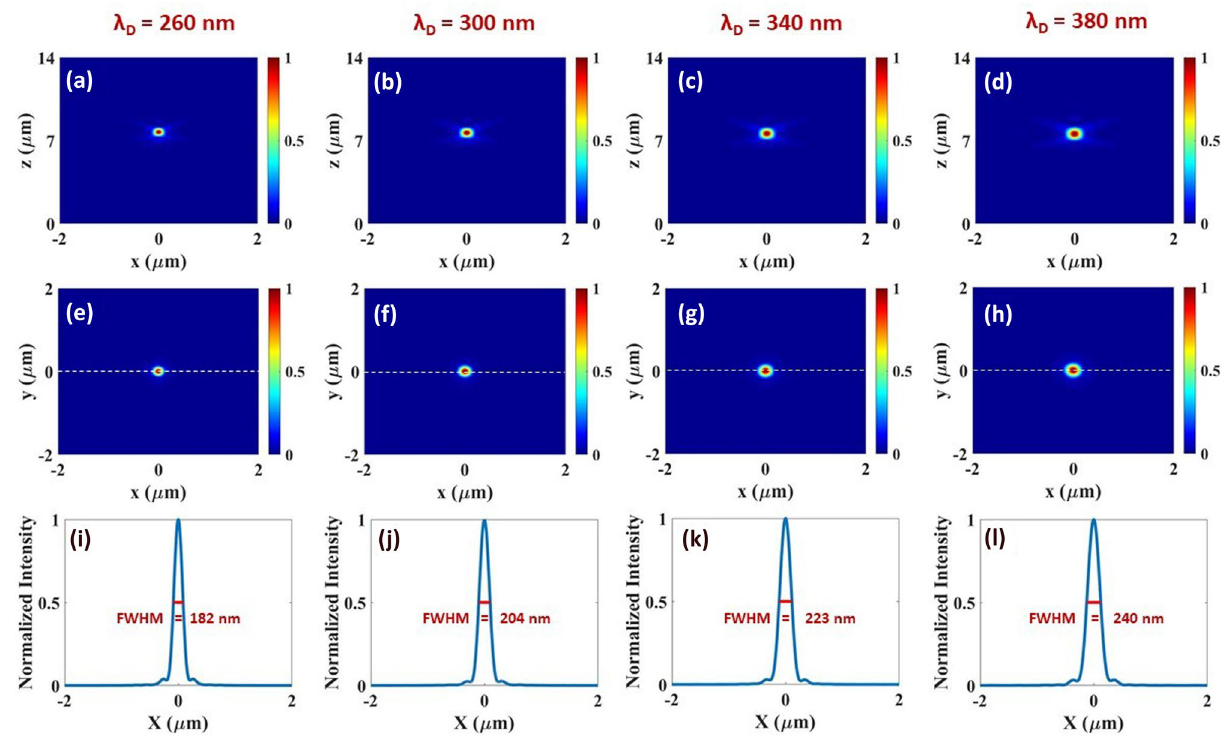
Figure 3. ( a – d ) Simulated normalized intensity profiles of focal spot at y = 0 ( x − z plane) for simple metalens at the designated wavelengths (cid:31) d = 260, 300, 340, 380 nm respectively. ( e – h ) Simulated normalized focal spot intensity profiles at z = f ( x − y plane) for the corresponding wavelength. ( i – l ) Normalized intensity profiles of focal spots presented at ( e – f ) along the dashed horizontal cut (at y = 0 ) for the corresponding wavelength. The profiles present full width at half maximum of 182, 204, 223, 240 nm respectively. Each metalens is illuminated by monochrome RCP incident light. All the metalenses have 20 µ m diameter, and the numerical aperture is calculated as (NA ≈ 0.8 ) at each